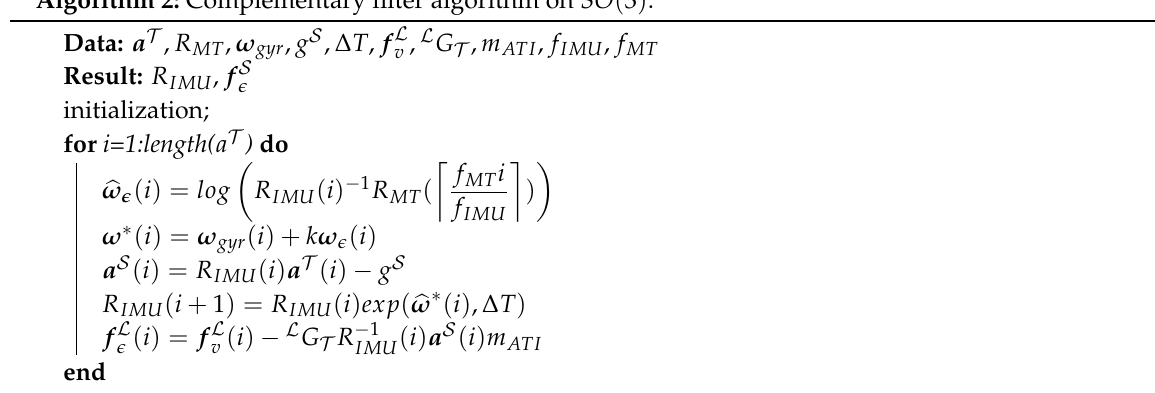
Algorithm 2: Complementary filter algorithm on SO ( 3 )